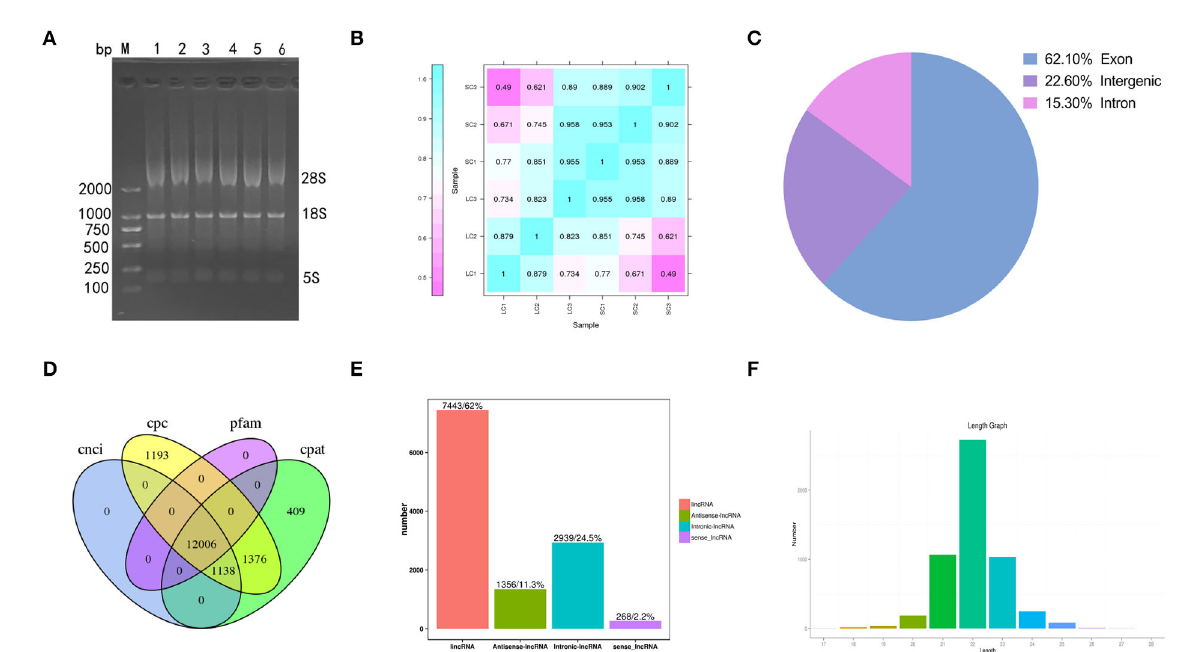
FIGURE2 Results of sequencing. (A) Gel electrophoresis of total RNA. (B) Heat maps of correlation among samples. (C) The ratios of mapped reads are located at different positions in the reference genome. (D) The prediction of lncRNAs by CPC2/CNCI/Pfam/CPAT. (E) The number and proportion of lincRNAs, antisense-lncRNAs, intronic-lncRNAs, and sense-lncRNAs. (F) The length distribution of known miRNAs.